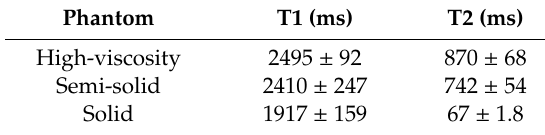
Table 3. MR relaxation times of the phantoms at the 1.5